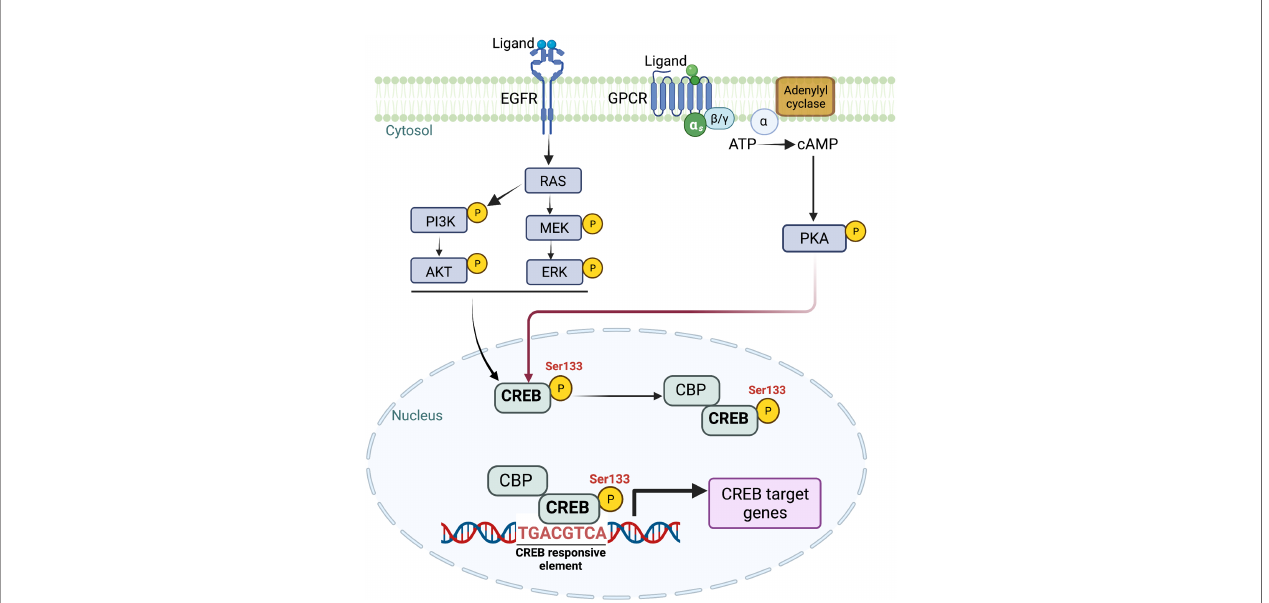
FIGURE 2 | Schematic representation of multiple upstream signaling cascades involved in intracellular CREB activation. CREB, once phosphorylated at Ser 133, translocates to the nucleus. Once translocated, CREB binds to CRE (cAMP response element) and provides transcriptional ability to activate multiple downstream targets. Image created with BioRender.com (Agreement number